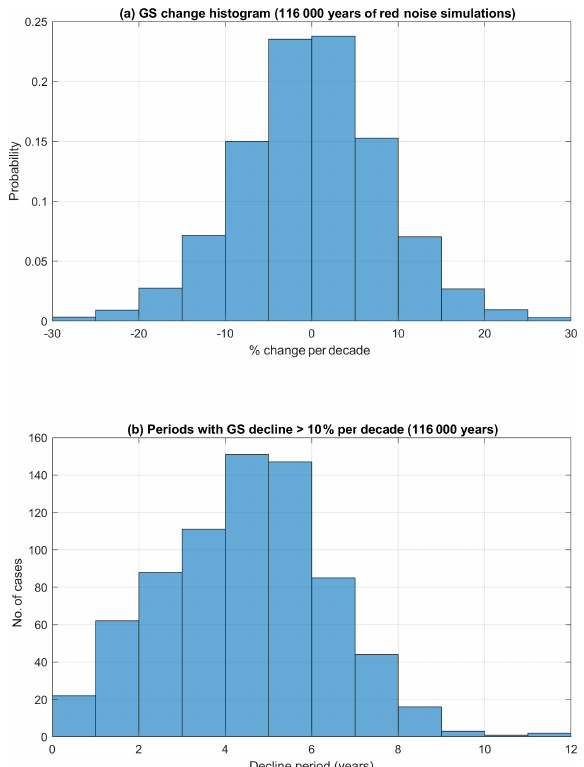
Figure A2. Histogram of the statistics of the GS-MAB flow changes using 1000 realizations of 116 years with random red noise (total of 116000 years); the simulations imitate the spectrum of the reconstructed GS in Fig. 9a. In each of these simulations GS change was calculated using EMD as in Fig. 9b. (a) The probability of obtaining different GS changes shows that the chance of GS weakening by over 20% per decade (as seen in the reconstruction) is less than 1% for any particular month. (b) The distribution of period length with GS flow declining by at least 10% per decade shows that there were only three cases of GS weakening that last at least 10 years during the 116000 years. For comparison, the GS-MAB in Fig. 9b shows two such cases in 116 years: a ∼ 10 year weakening period in the 1970s and a ∼ 15 year weakening period in the